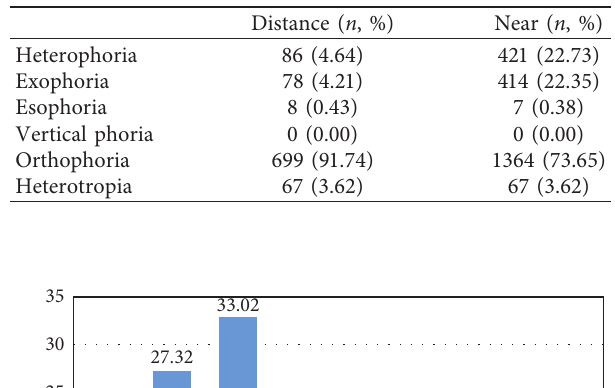
Table 3: Prevalence of heterophoria, orthophoria, and heterotropia for grade-one pupils at near and distance fixation.